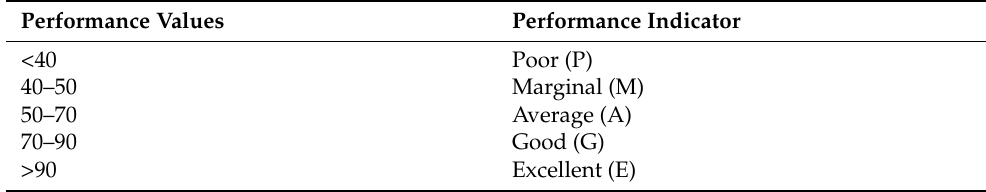
Table 4. Performance